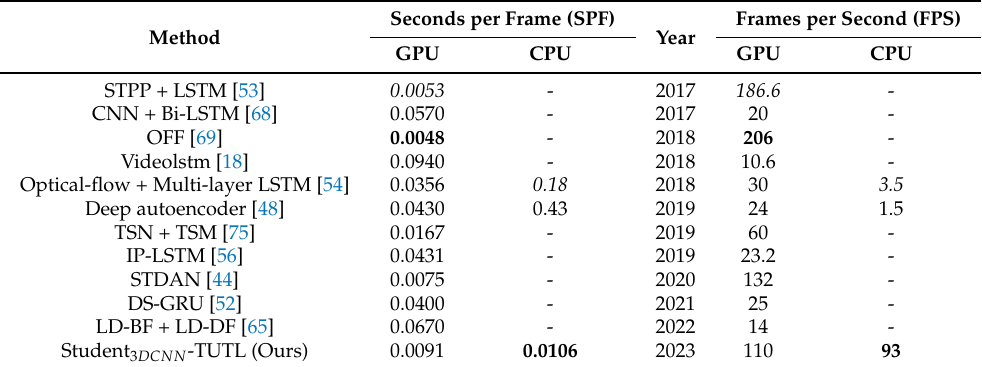
Table 15. Run time analysis of our proposed framework with the state-of-the-art human action recognition methods (without scaling).